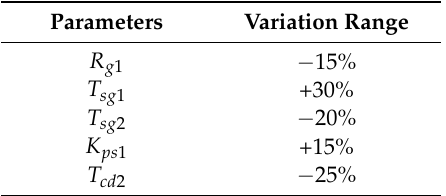
Table 4. The variation range of the parameters.